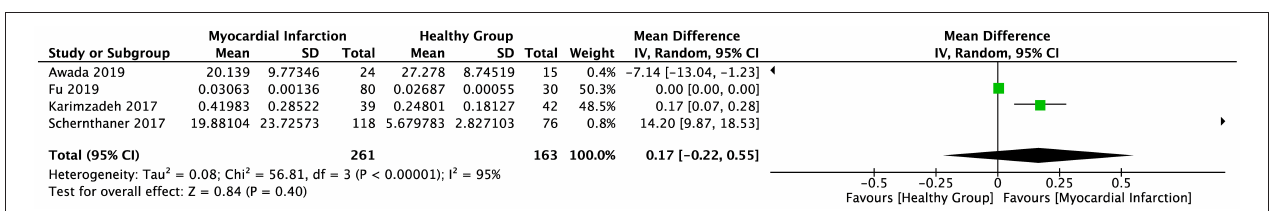
FIGURE 4 | Forest plot of sST2 levels between MI and healthy groups.